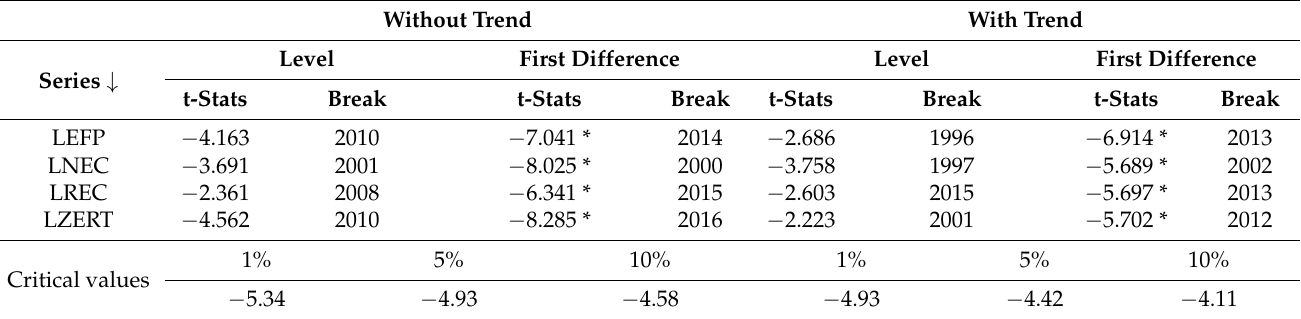
Table 6. Zivot and Andrews’ unit root findings (with Structural